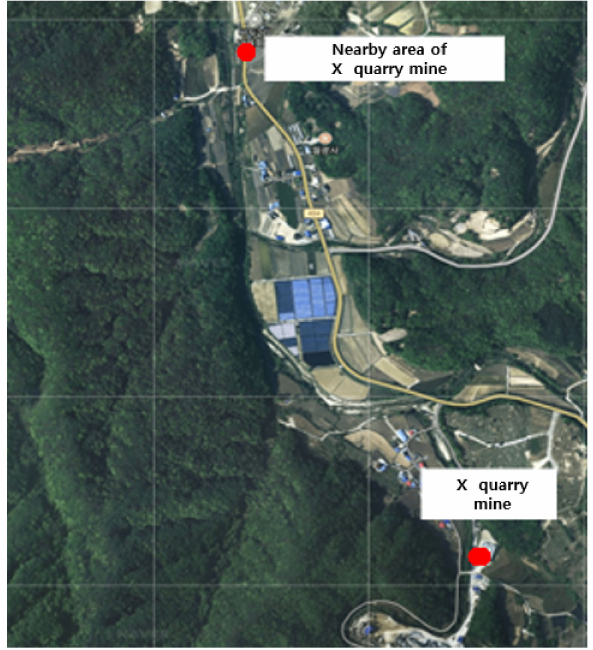
Figure 4. The locations of X quarry and the nearby area used for determining the background